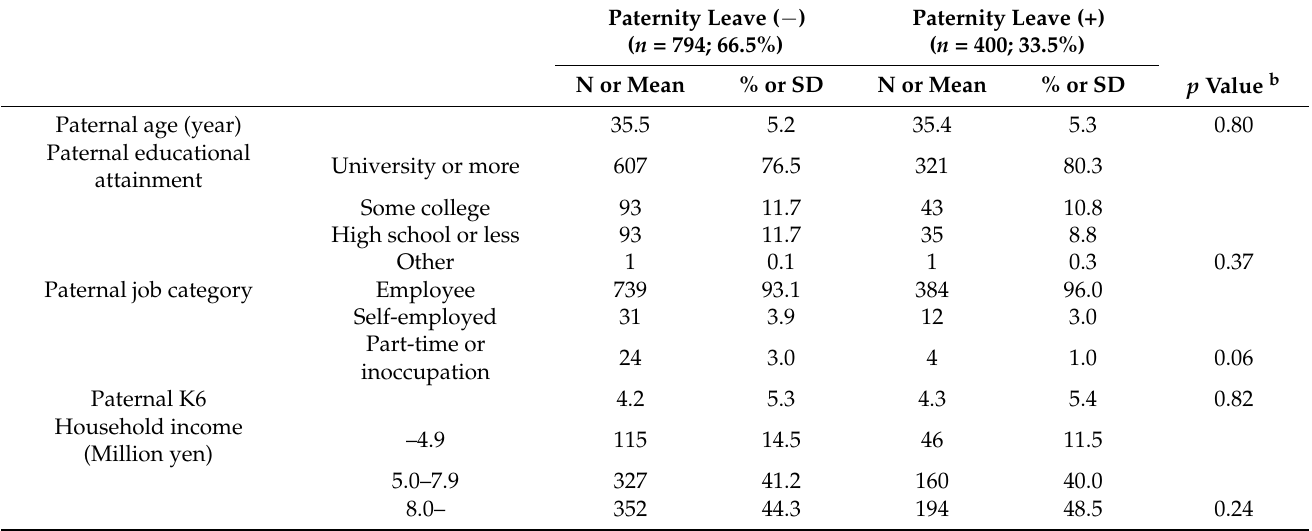
Table 1. Demographics of study participants ( n =